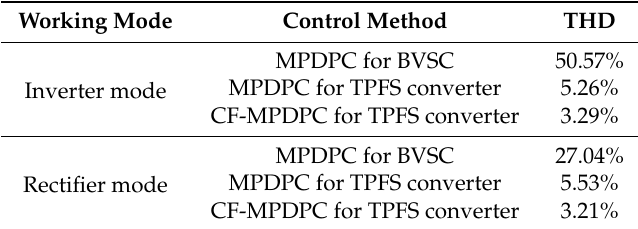
Table 4. Experimental comparison of current THD.